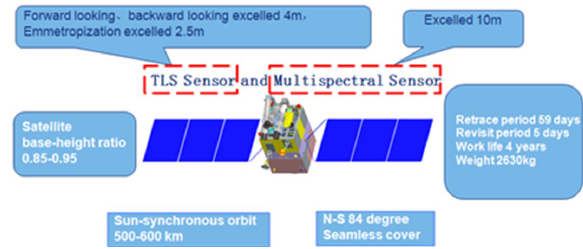
Figure 1: ZY-3 high-resolution stereo mapping satellite